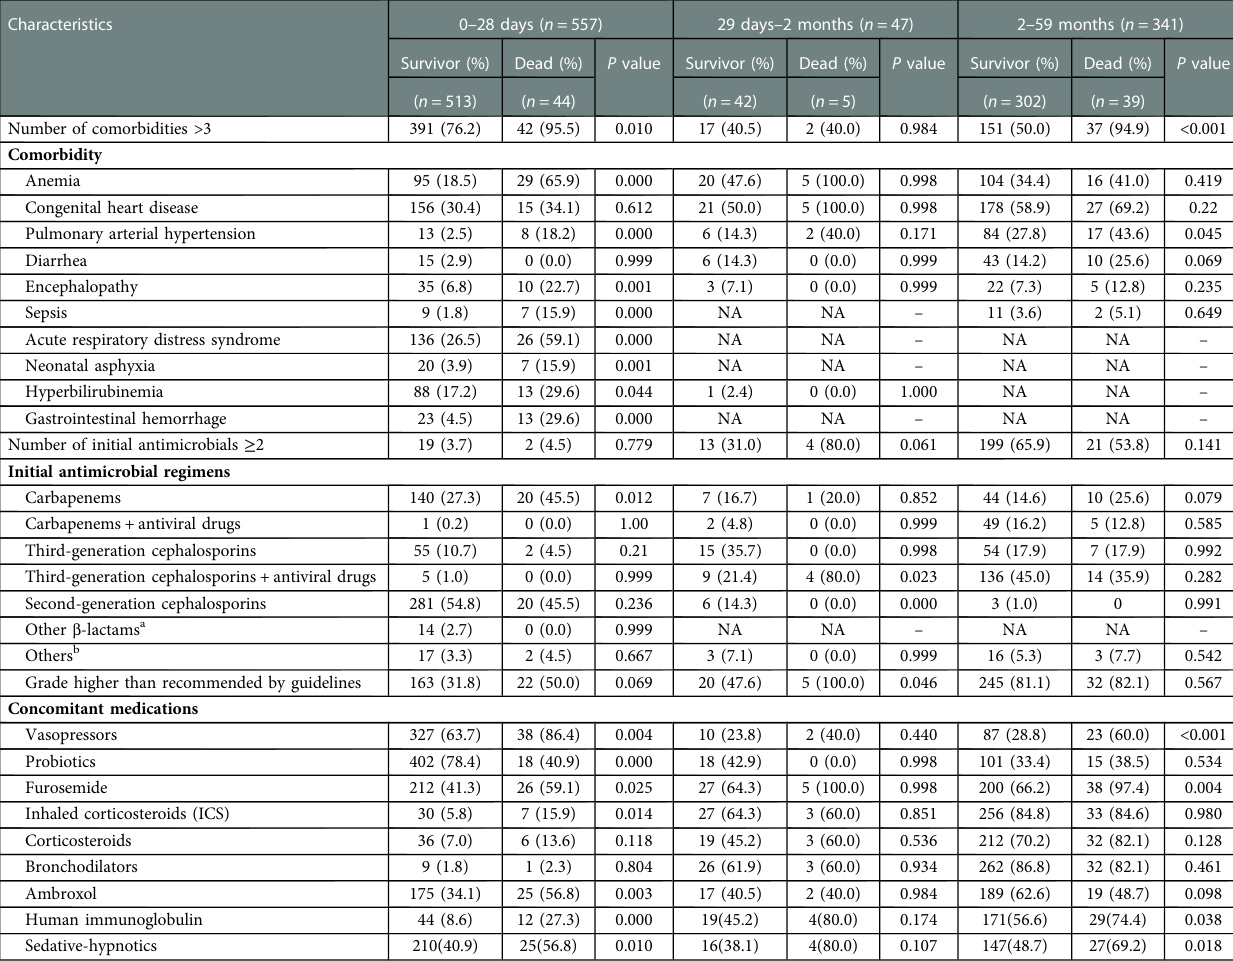
TABLE 2 Comorbidities and medications of 945 infants and young children with severe CAP in PICUs.